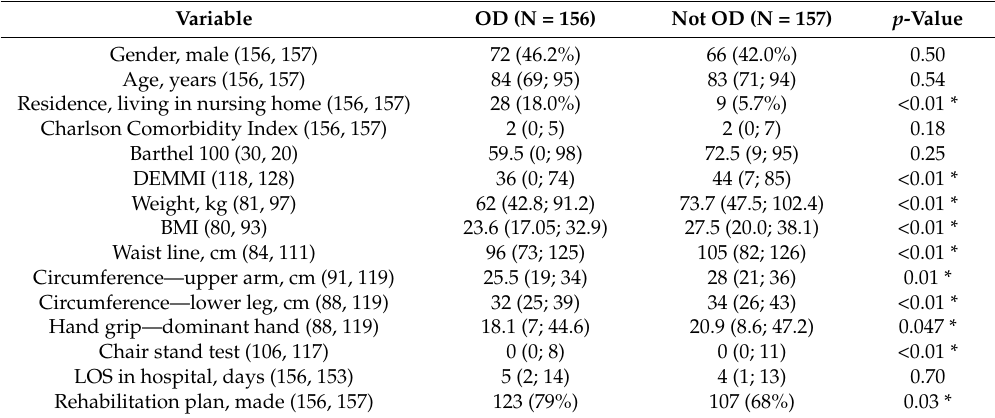
Table 1. Baseline demographics and clinical characteristics between patients with OD vs. patients with no OD. The numbers in parenthesis after the variable name represent the number of patients in each group with available information for that variable. Significant results present an asterisk after the p -value.